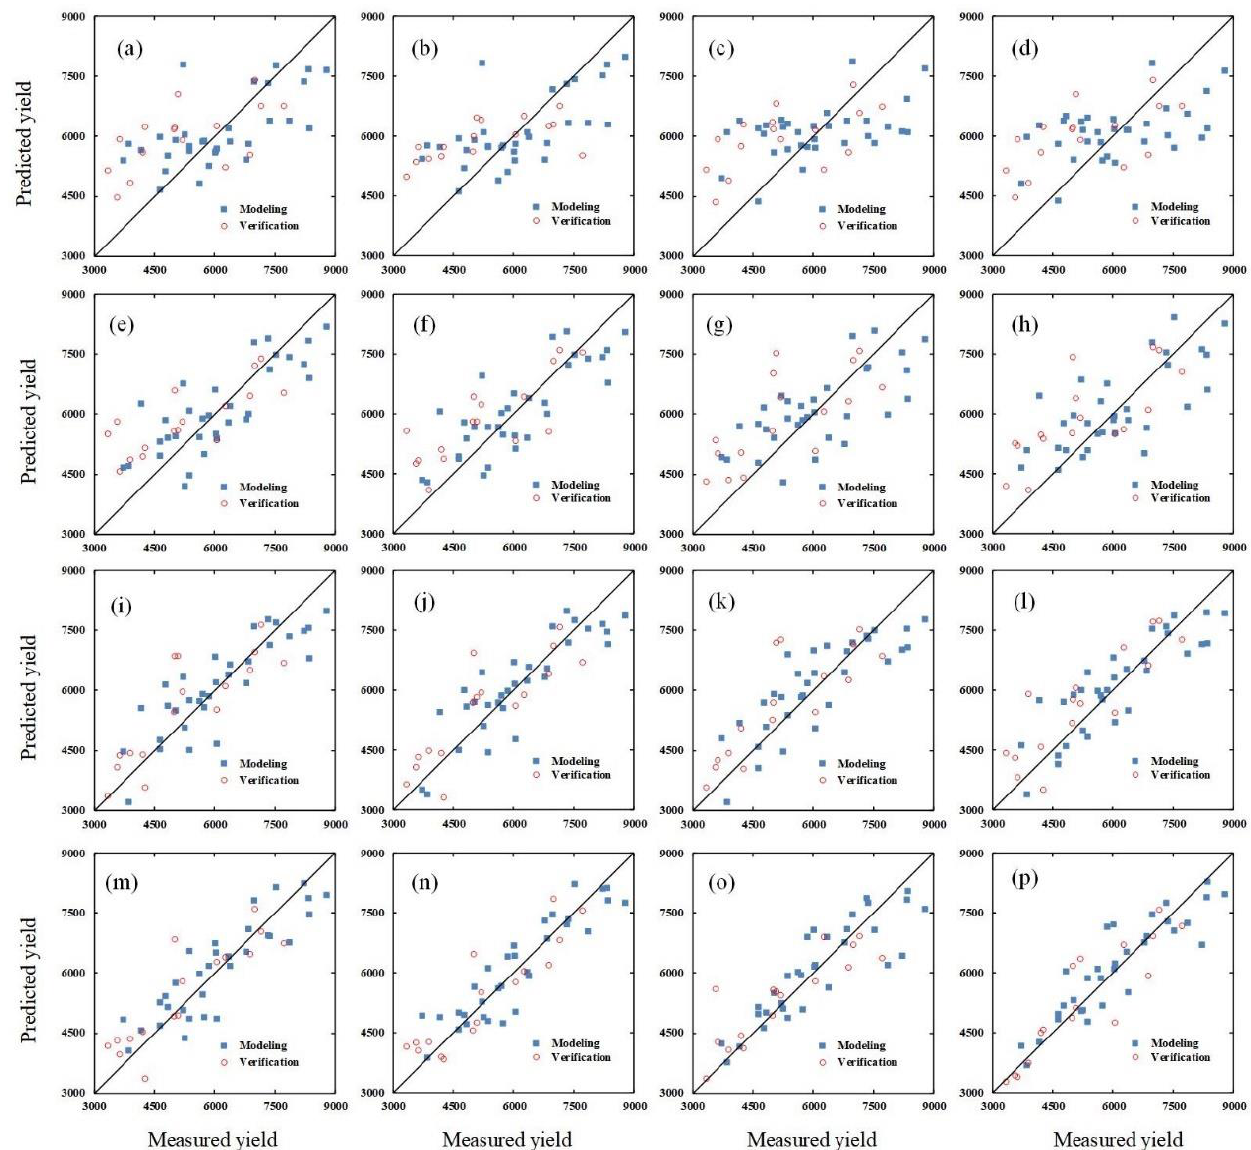
Figure 2. Relationships between the measured winter wheat yield (kg/ha) and the yield predicted using partial least squares regression (PLSR) based on ( a ) VIs based on near-surface hyperspectral data collected with the ASD FieldSpec 3 spectrometer (ASD-VIs) at the jointing stage; ( b ) a combination of ASD-VIs and a red-edge parameters (REP) based on near-surface hyperspectral data collected with the ASD FieldSpec 3 spectrometer (ASD-REP) at the jointing stage; ( c ) VIs based on UAV hyperspectral data collected with the UHD 185-Firefly hyperspectral sensor (UHD185-VIs) at the jointing stage; ( d ) a combination of UHD185-VIs and REPs based on UAV hyperspectral data col- lected with the UHD 185-Firefly hyperspectral sensor ( UHD185-REP) at the jointing stage; ( e ) ASD- VIs at the flagging stage; ( f ) a combination of ASD-VIs and ASD-REP at the flagging stage; ( g ) UHD185-VIs at the flagging stage; ( h ) a combination of UHD185-VIs and UHD185-REP at the flag- ging stage; ( i ) ASD-VIs at the flowering stage; ( j ) a combination of ASD-VIs and ASD-REP at the flowering stage; ( k ) UHD185-VIs at the flowering stage; ( l ) a combination of UHD185-VIs and UHD185-REP at the flowering stage; ( m ) ASD-VIs at the filling stage; ( n ) a combination of ASD-VIs and ASD-REP at the filling stage; ( o ) UHD185-VIs at the filling stage; ( p ) a combination of UHD185- VIs and UHD185-REP at the filling stage.